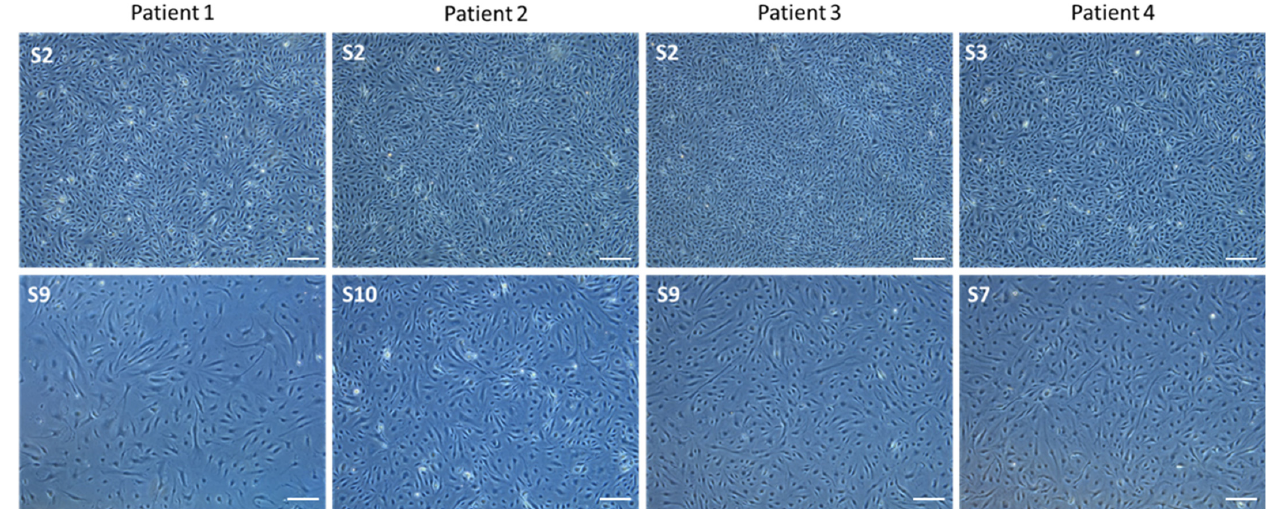
Figure 3. Representative pictures of PAECs in culture isolated from 4 different patients at right heart catheterization using Swan-Ganz pulmonary arterial catheters. ( upper panel ): early subcultures; ( lower panel ): advanced subcultures. Scale = 200 µm.